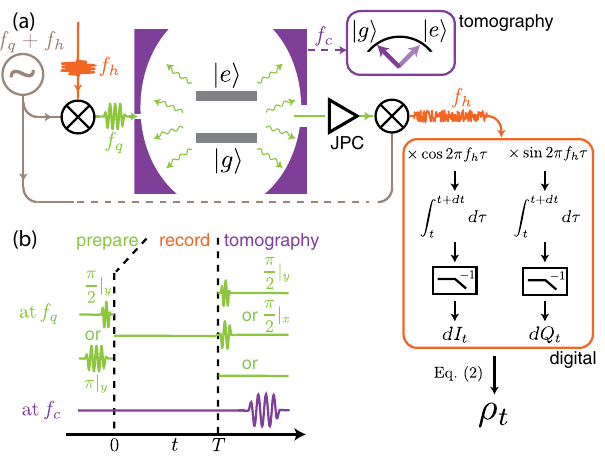
y σ z σ = 2 and the x þ y þ z Þ 0 . 42 (cid:2) 0 . 02 , traj ¼